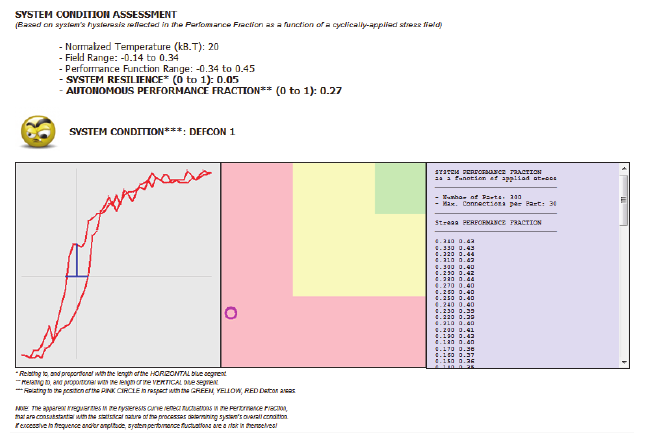
Figure 10 . System response to cyclic stress (hysteresis pattern) for a 20% technology